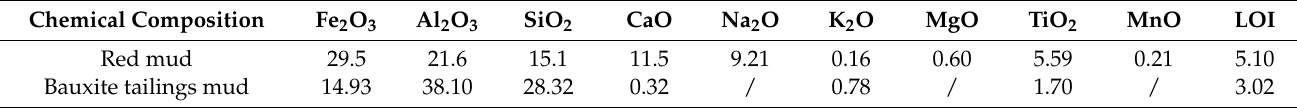
Table 1. Main mineral composition of mud (wt%).